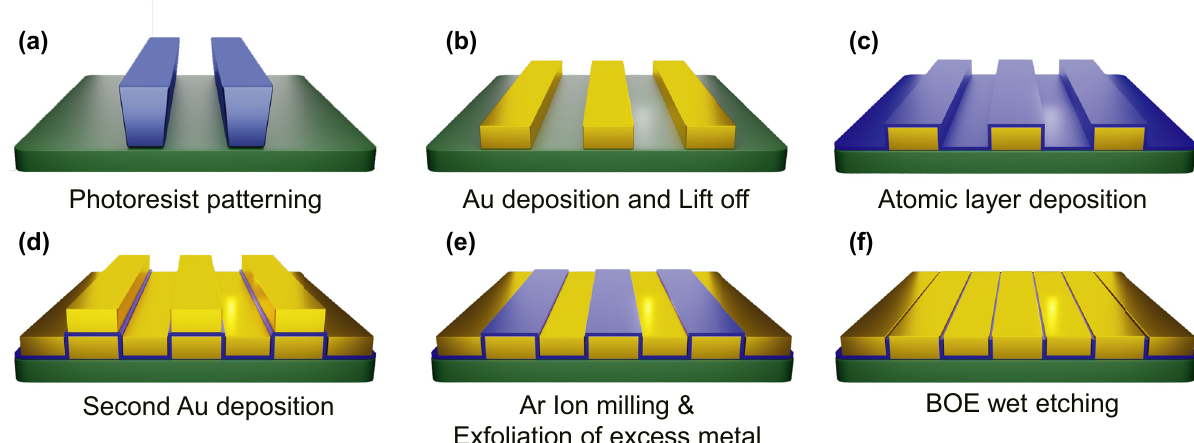
Figure 2: Schematic diagram of the fabrication process of the gold nanogap-loop array. (a) Photoresist patterns are fabricated by conventional photolithography on a silicon wafer. (b) Subsequent Au deposition and lift-off processes are performed to obtain the rectangular shape metal patterns. (c) The patterned metal substrate is conformally coated with a 20 nm thick Al is performed to fill inside the rectangular hole arrays. (e) Ar-ion milling is performed before peeling off. The excess metals atop the patterned metal substrate are exfoliated using adhesive tape. (f) Partially remaining Al